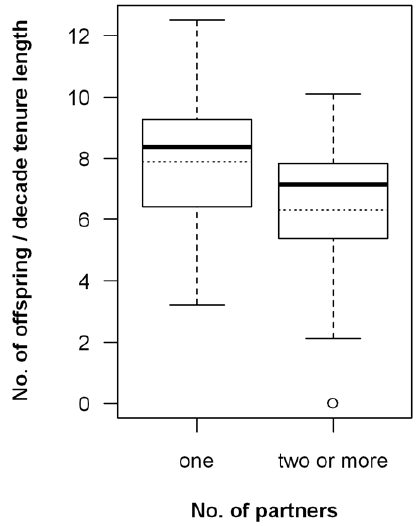
Figure 1. Number of infants per decade of tenure length (infants/10ytl). The boxplot show medians (solid line), means (dotted line) and interquartile ranges for individuals with one or with two or more partners during their tenure. The whiskers give the range except for ‘‘outliers’’ that are more than 6 1.5 times the inter-quartile range larger or smaller than the median.